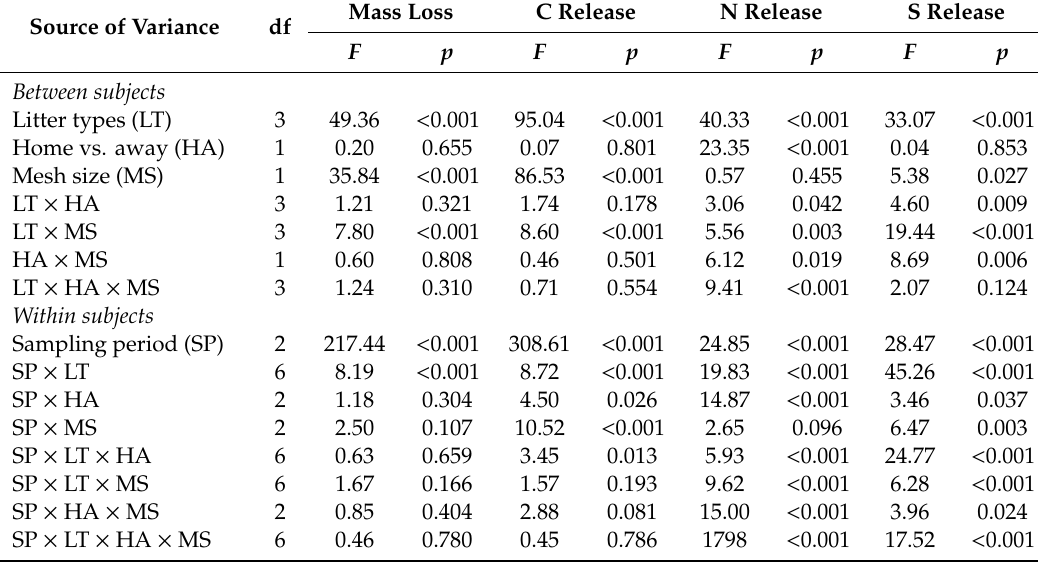
Table 1. Results of a repeated measures ANOVA on the e ff ects of litter types (LT), home vs. away (HA), mesh size (MS), sampling period (SP), their activities in litter mass loss, and C, N, and S release. Statistically significant ( p < 0.05) results are shown in